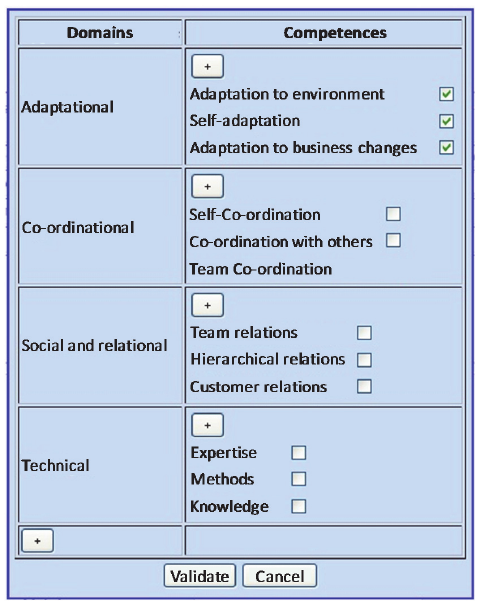
Fig. 5. Competences and Type of Competences